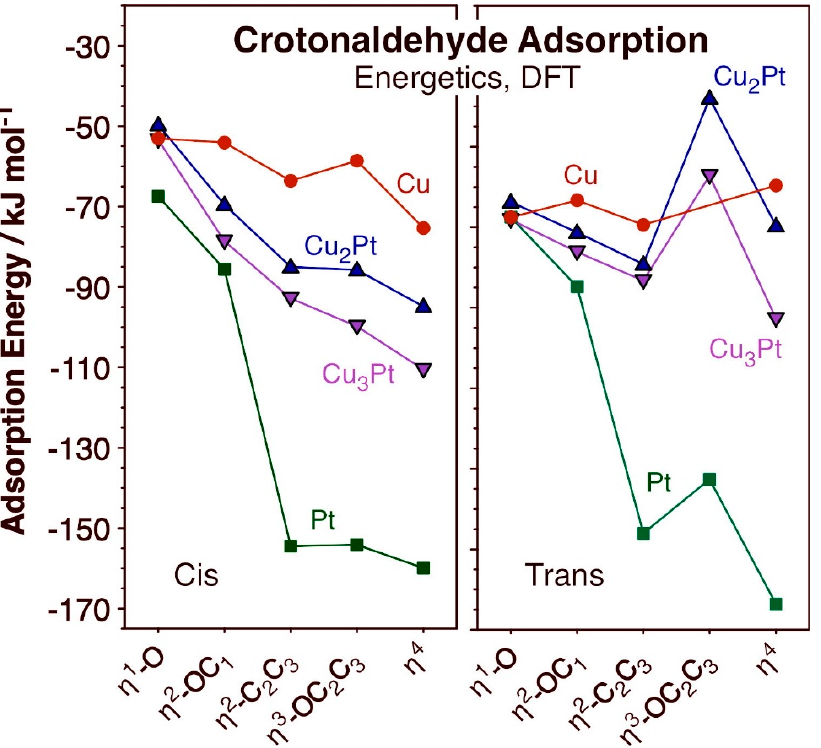
Figure 3. Energies of adsorption for the cis (left panel ) and trans ( right ) configurations of crotonaldehyde on Cu (red circles), Cu 3 Pt (pink downward-pointing triangles), Cu 2 Pt (blue upward-pointing triangles), and Pt (green squares) as a function of coordination mode to the surface, for the structures shown in Figure 2. Table 1. Calculated bond lengths for the E-(s)-cis crotonaldehyde in the different configurations considered in this work. Values for bonding to either Cu or Pt are indicated by the color of the numbers, blue for Cu and grey for Pt.